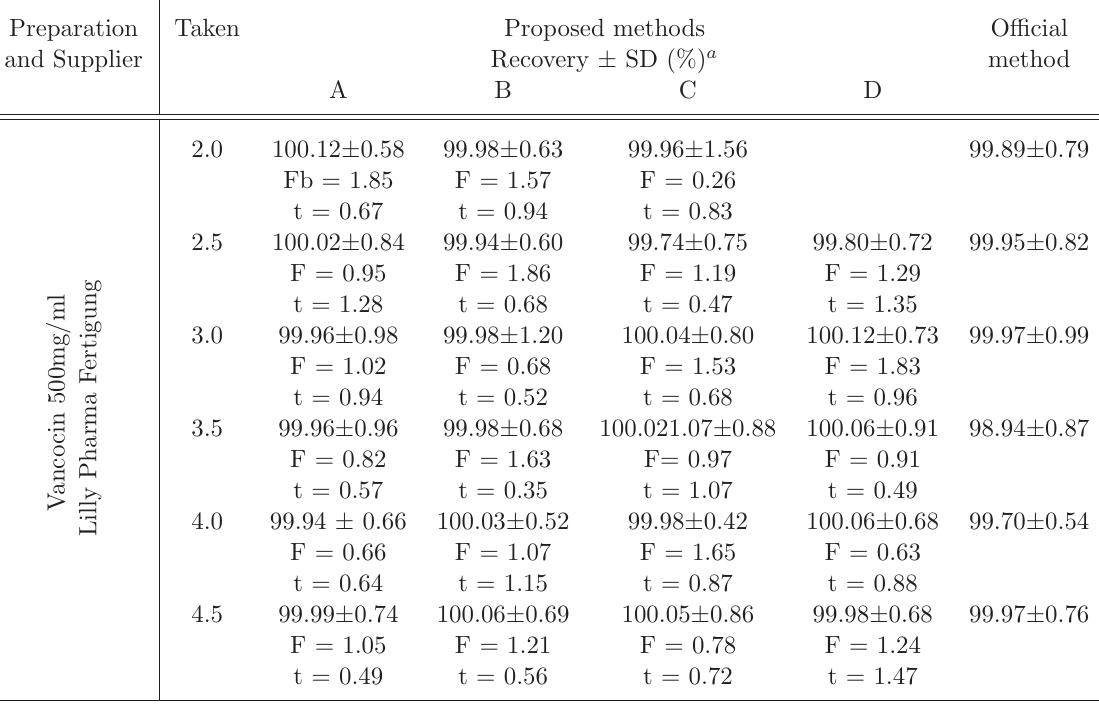
a The average of six determinations. b Theoretical values for t- and F-values for five degrees of freedom and 95% confidence limits are 2.57 and 5.05,